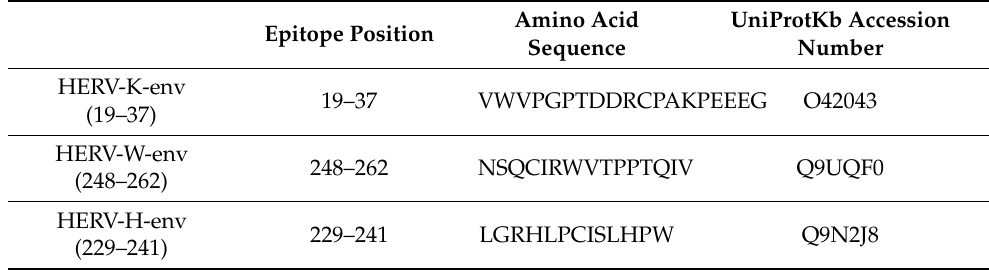
Table 2. Position and amino acid sequence of the epitopes utilised in the indirect ELISA